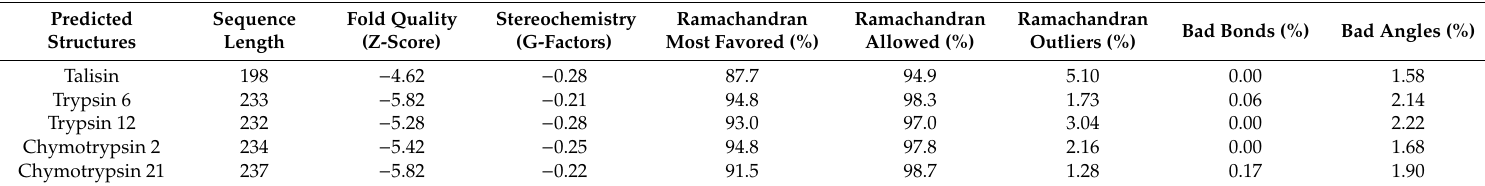
Table 3. Structural statistics for the tridimensional theoretical models generated in this study for talisin, trypsin (6 and 12) and chymotrypsin (2 and 21). Predicted Structures